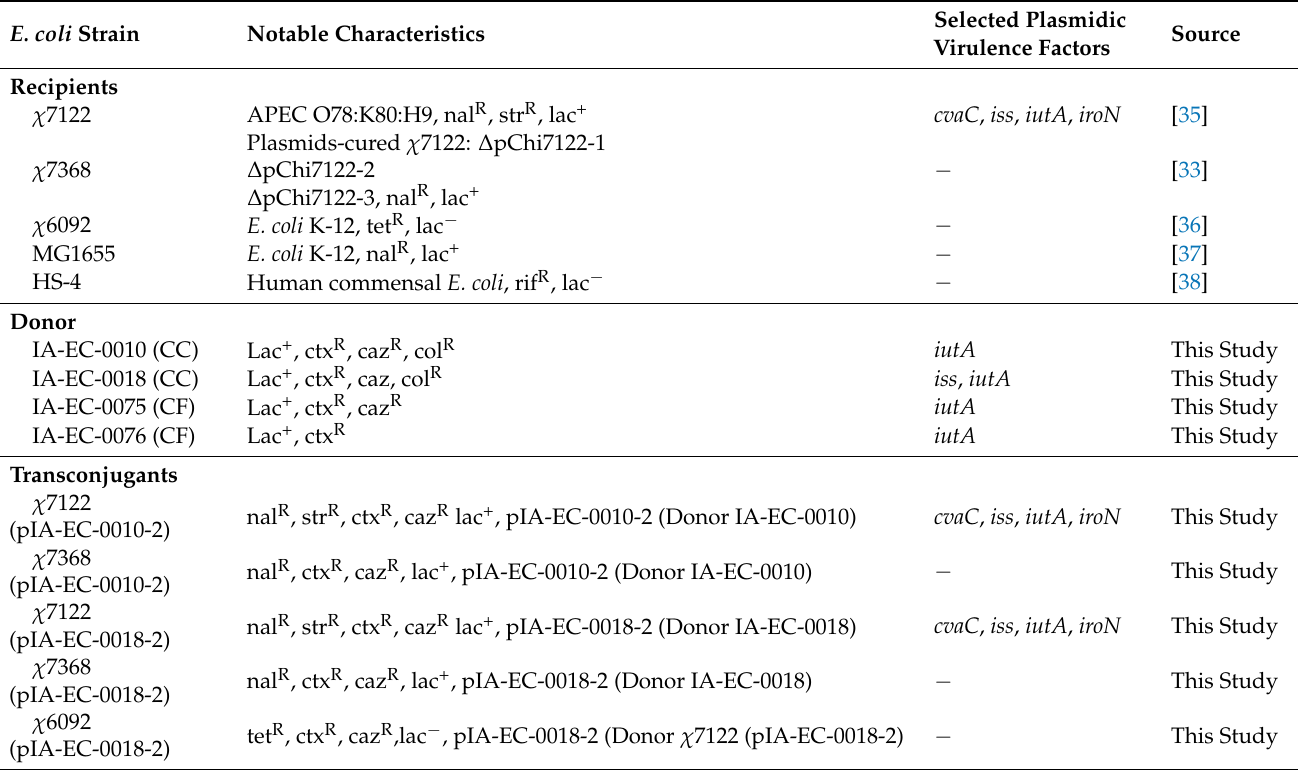
Table 1. Relevant characteristics of donor and recipient